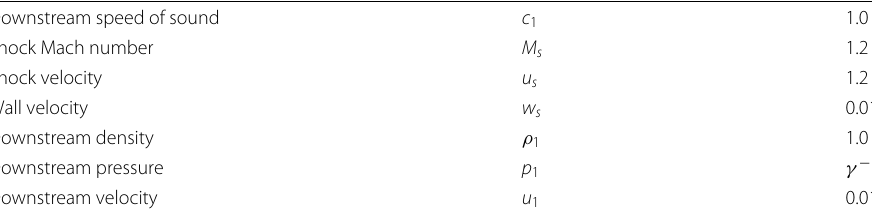
Table 1 Initial condition of the shock state